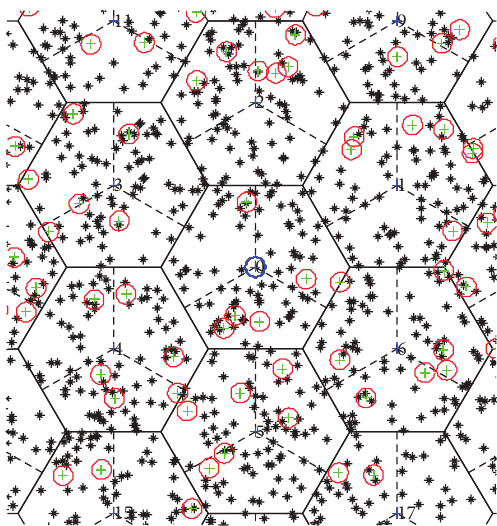
Figure 3: Cell layout and user distribution in uniform scenario.